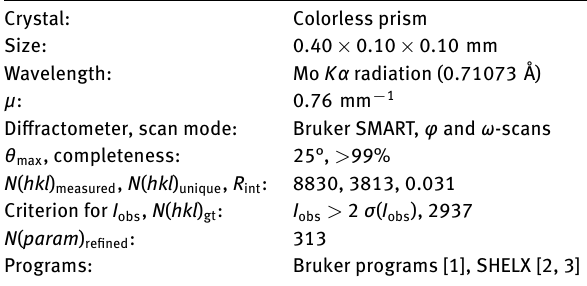
Table 1: Data collection and